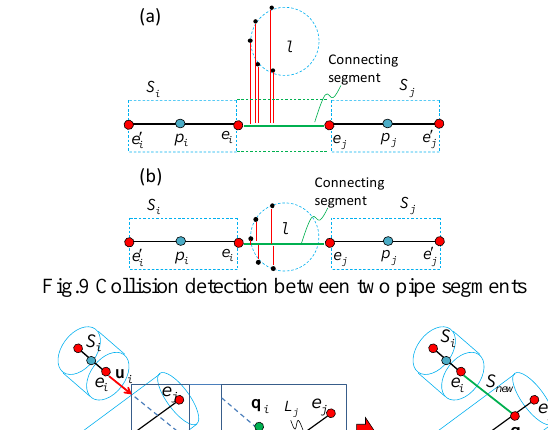
Fig.8 Interpolation of occluded portions